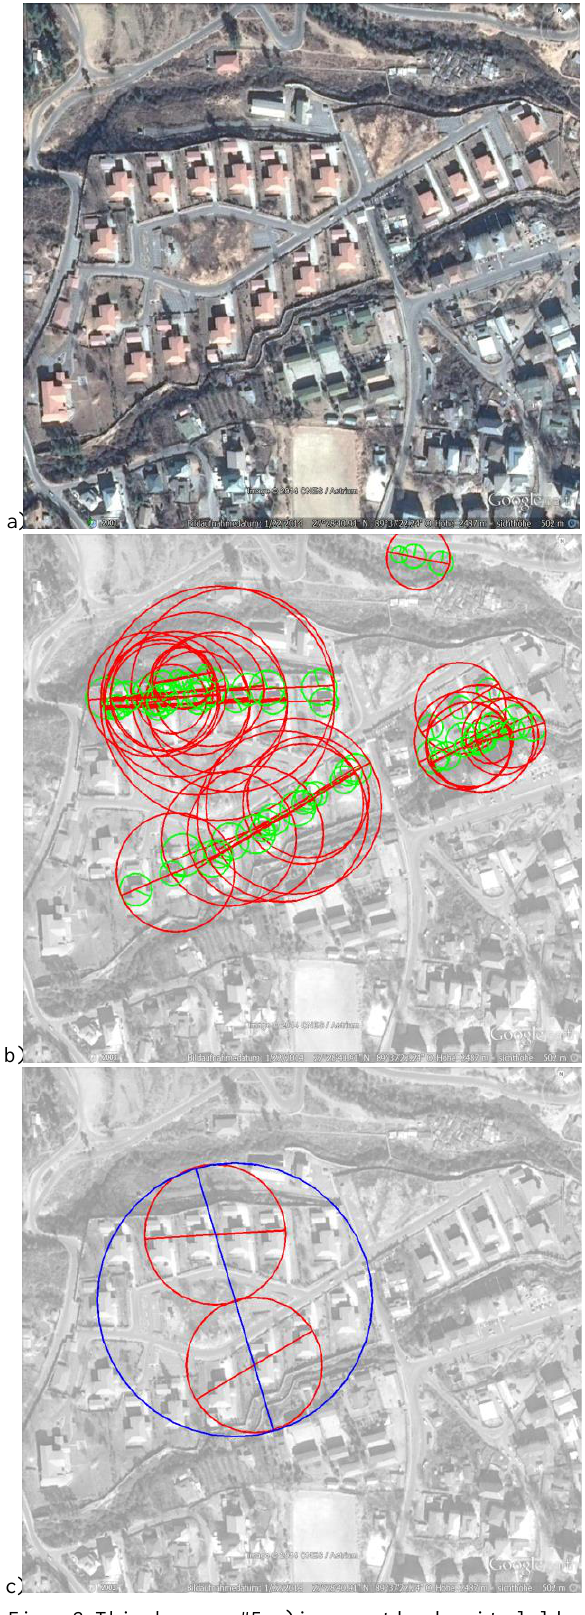
Figure 2. Thimphu scene #5: a) image as taken by virtual globe system; b) rows of primitive Gestalten ∑ P…P surpassing assessment 0.8; c) the best mirror-of-row